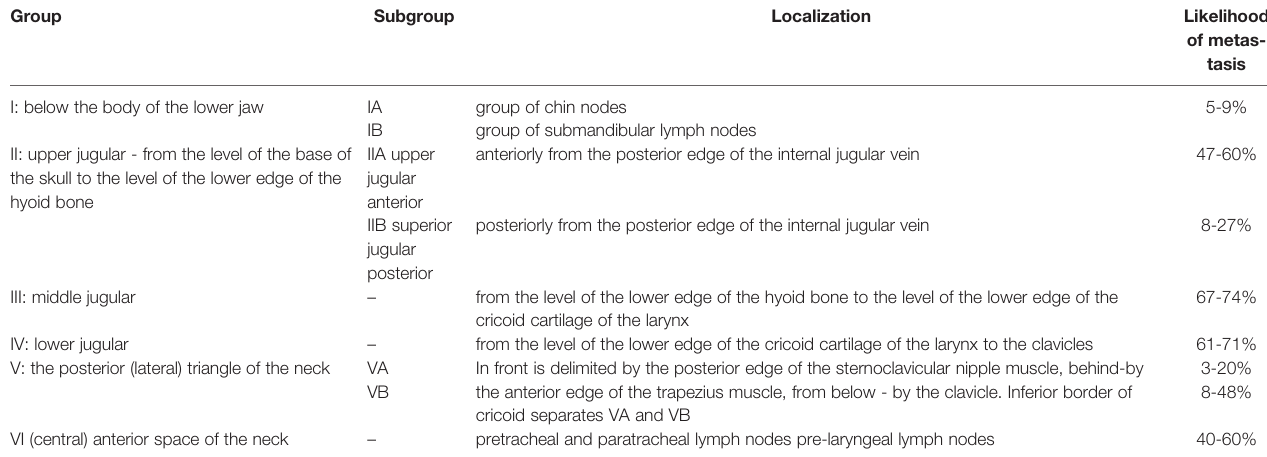
TABLE 1 | Groups and localization of lymph